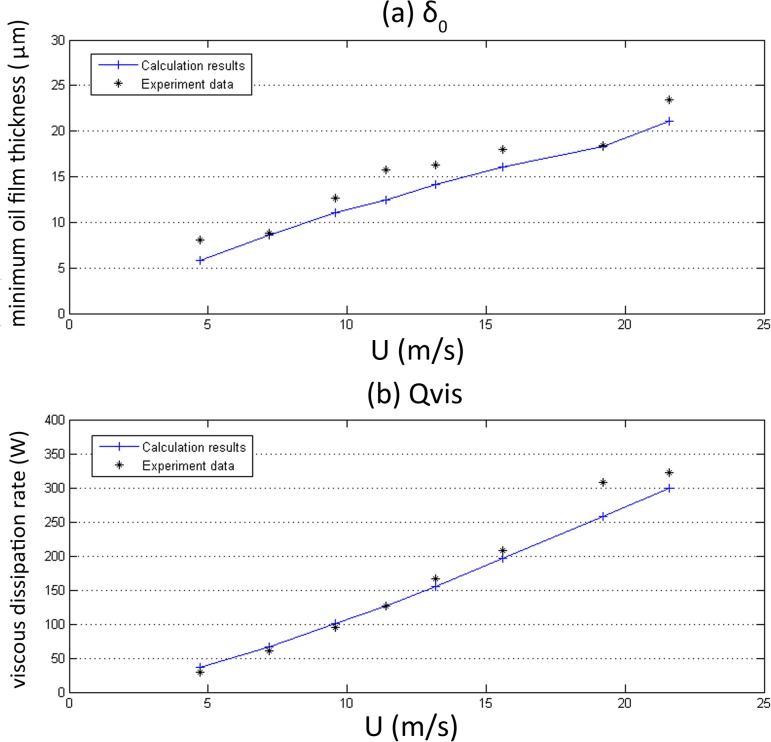
Comparison between experimental data and numerical results.